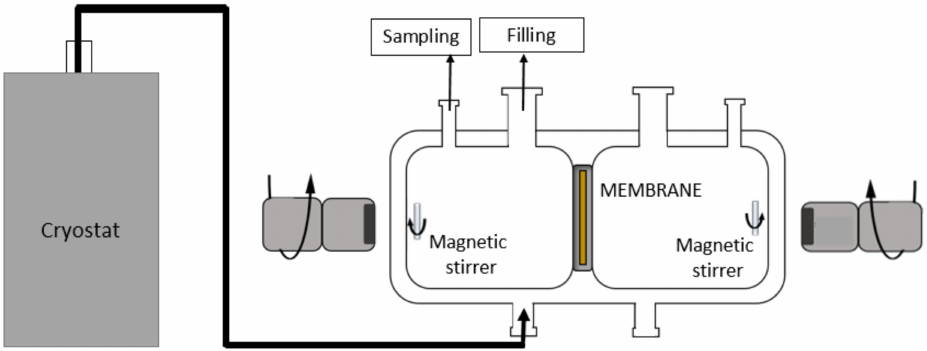
Figure 3. The scheme of the pertraction setup